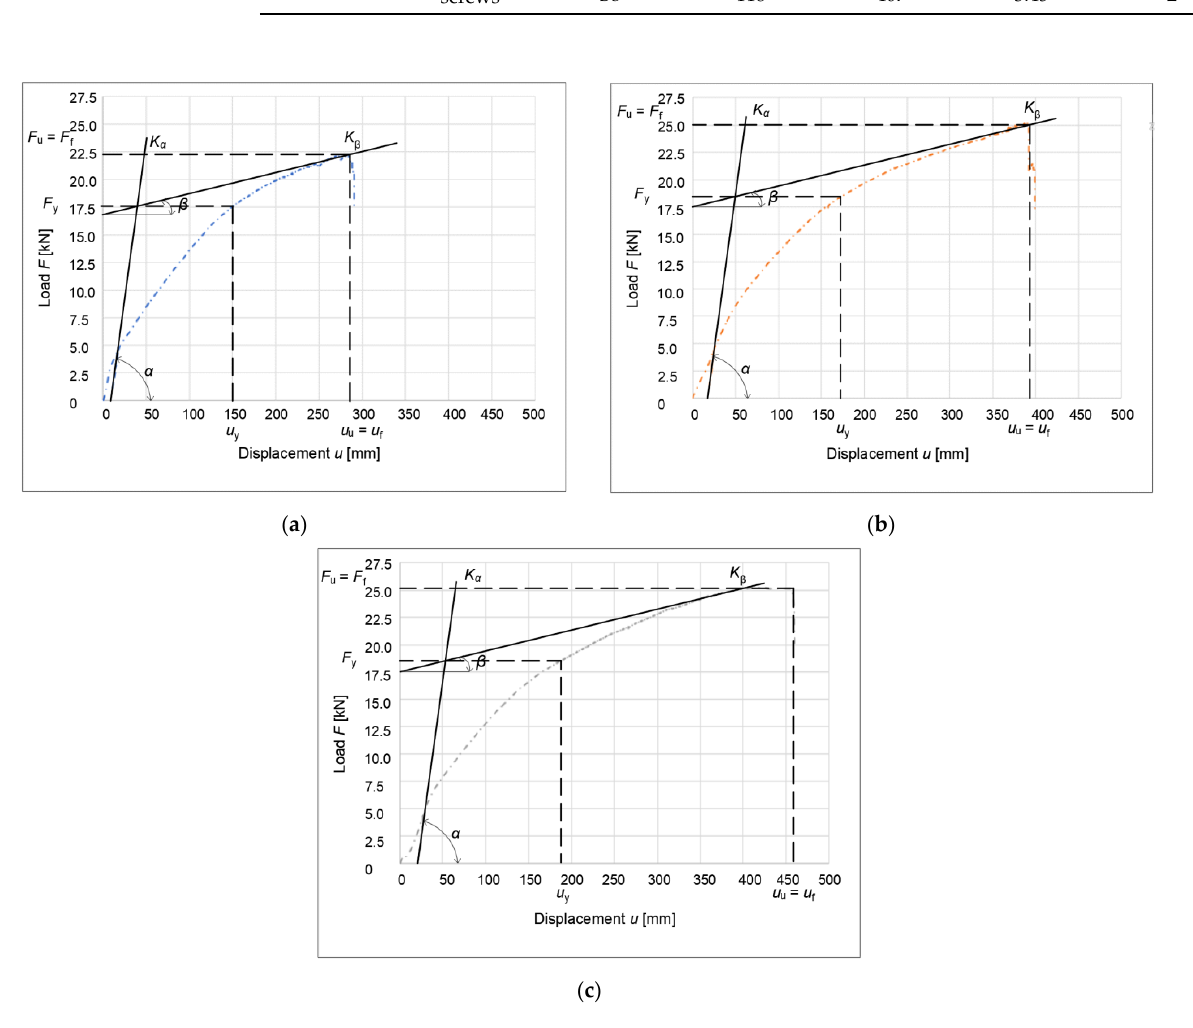
Figure 18. Graphical representation of the yield strength of a connection formed with screws ac- cording to EN 12512: ( a ) unreinforced specimen; ( b ) reinforced partitions; and ( c ) reinforced rung and struts (stands). Another method used to obtain ductility is that described by Yasamura and Kawai (1998) [14]. This method is very similar to the method described in EN 12512 [13]. The difference, however, is in obtaining the yield point; in this method, the deformation at the yield point is subtracted by intersecting a horizontal line with the working diagram of the connection. In the standard method, this value is read by crossing a vertical line with a working diagram. Figures 19 and 20 show a graphical method for obtaining ductility ac- cording to Yasamura and Kawai (1998) [14].